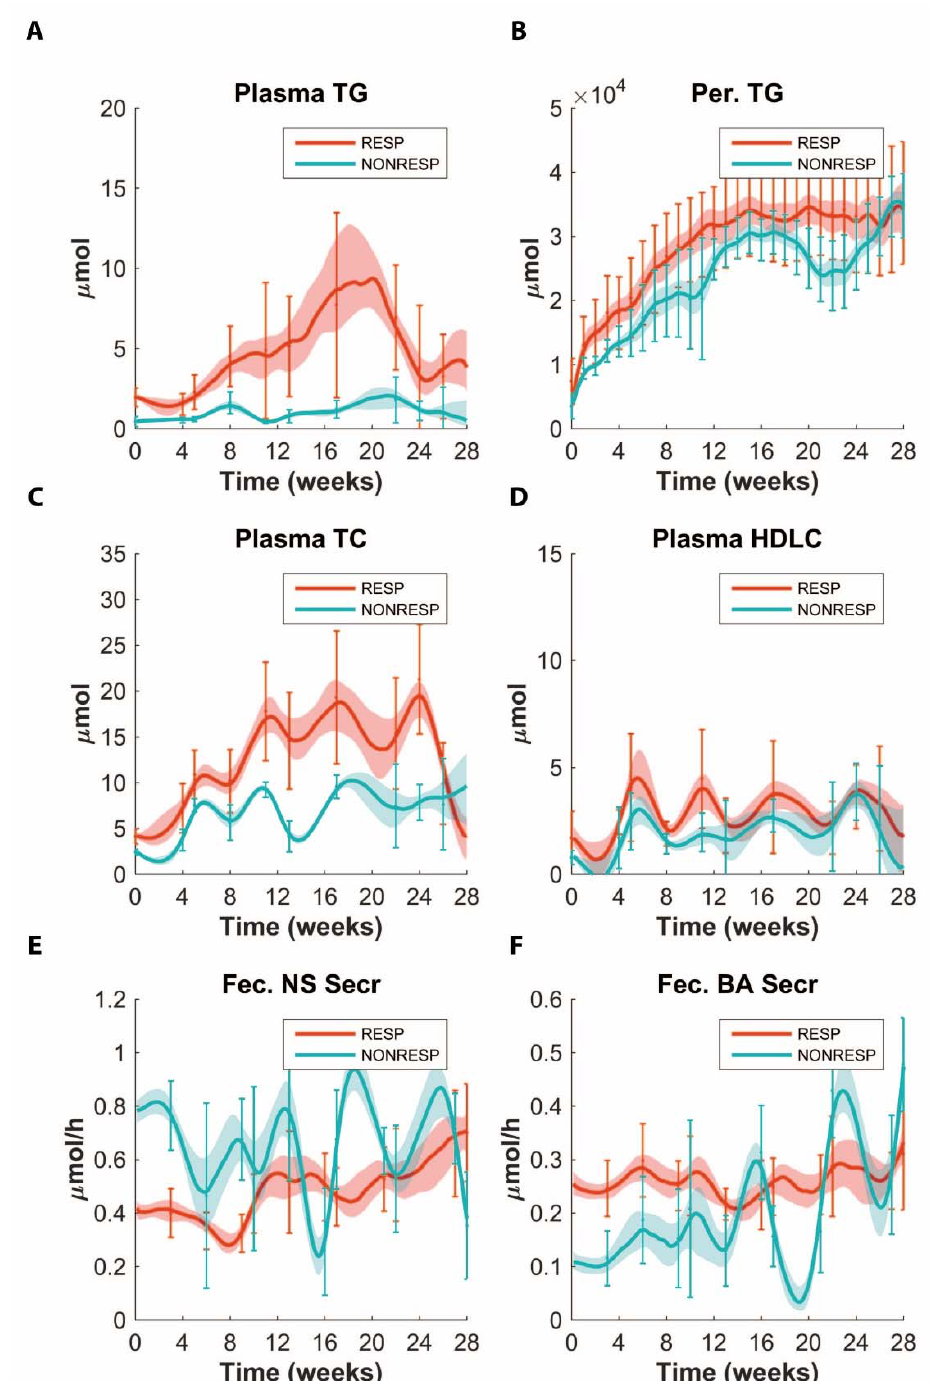
Figure 2. Plasma TG ( A ) and peripheral fat (Per. TG ( B )), plasma total cholesterol (TC) ( C ), HDL cholesterol (HDLC) ( D ), fecal neutral sterol secretion ( E ) (Fec. NS Secr) and fecal bile acid secretion ( F ) (Fec. BA Secr) for responders (RESP) and non-responders (NONRESP), respectively, with their respective fits in the ADAPT model simulation. Note that non-responders are marked by lower plasma TG and less peripheral fat. Error bars represent data with standard deviation, bold lines represent the median solution of all ADAPT simulations and the areas represent 30% around the median solution.